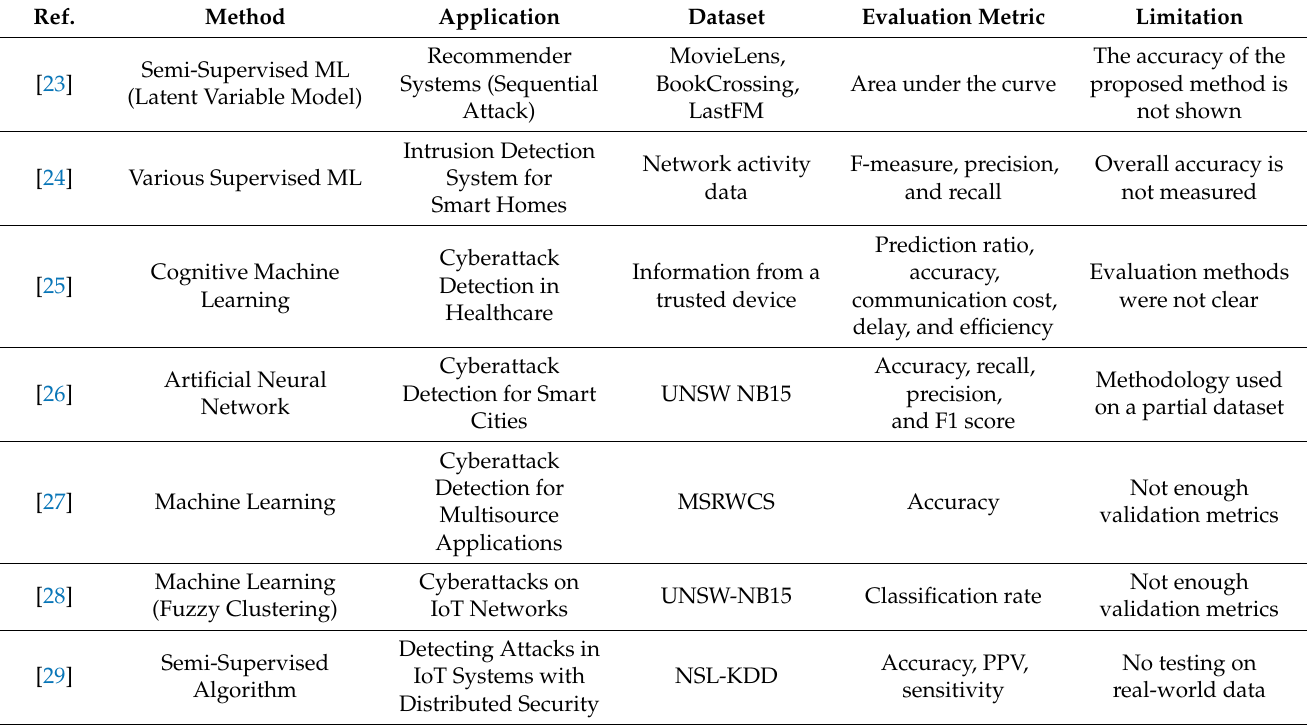
Table 1. A summary of machine learning methods for cyberattack detection.